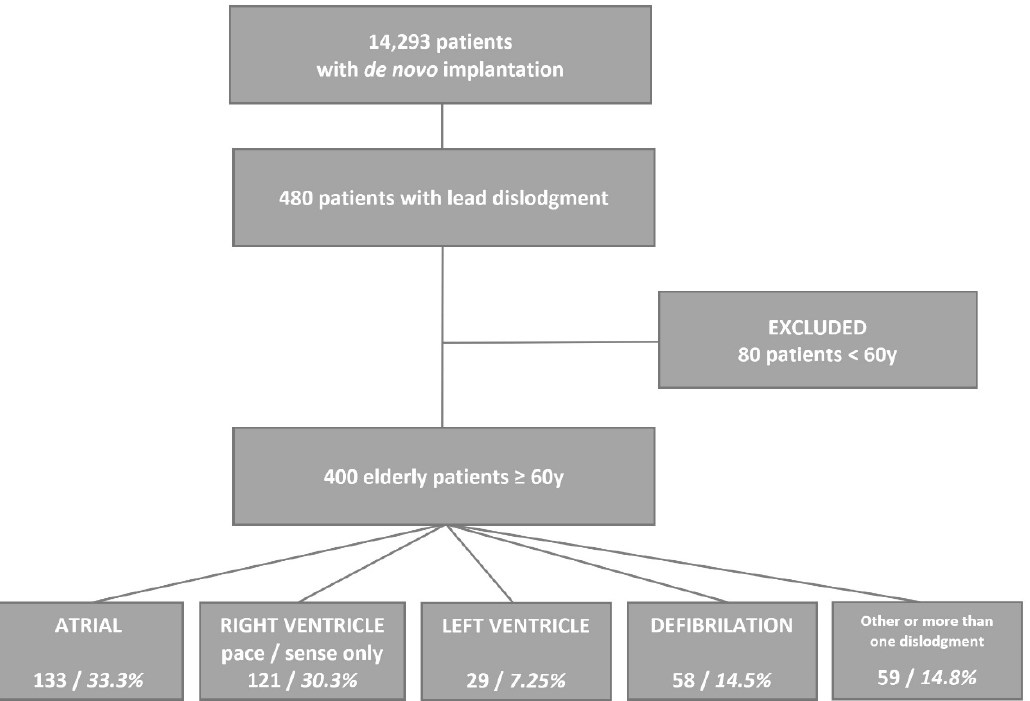
Figure 1. Study design and patient selection.